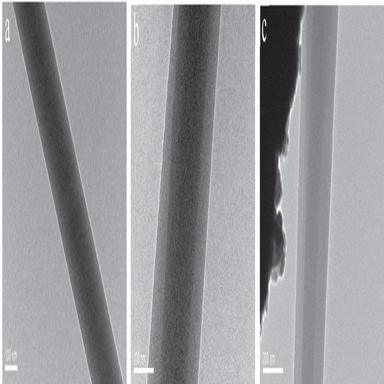
TEM images of different nanofibers.